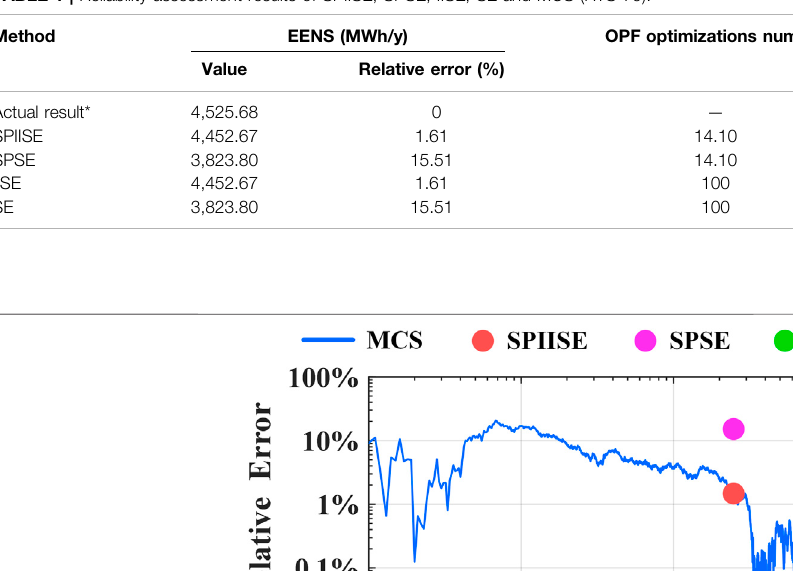
TABLE 1 | Reliability assessment results of SPIISE, SPSE, IISE, SE and MCS (RTS-79).